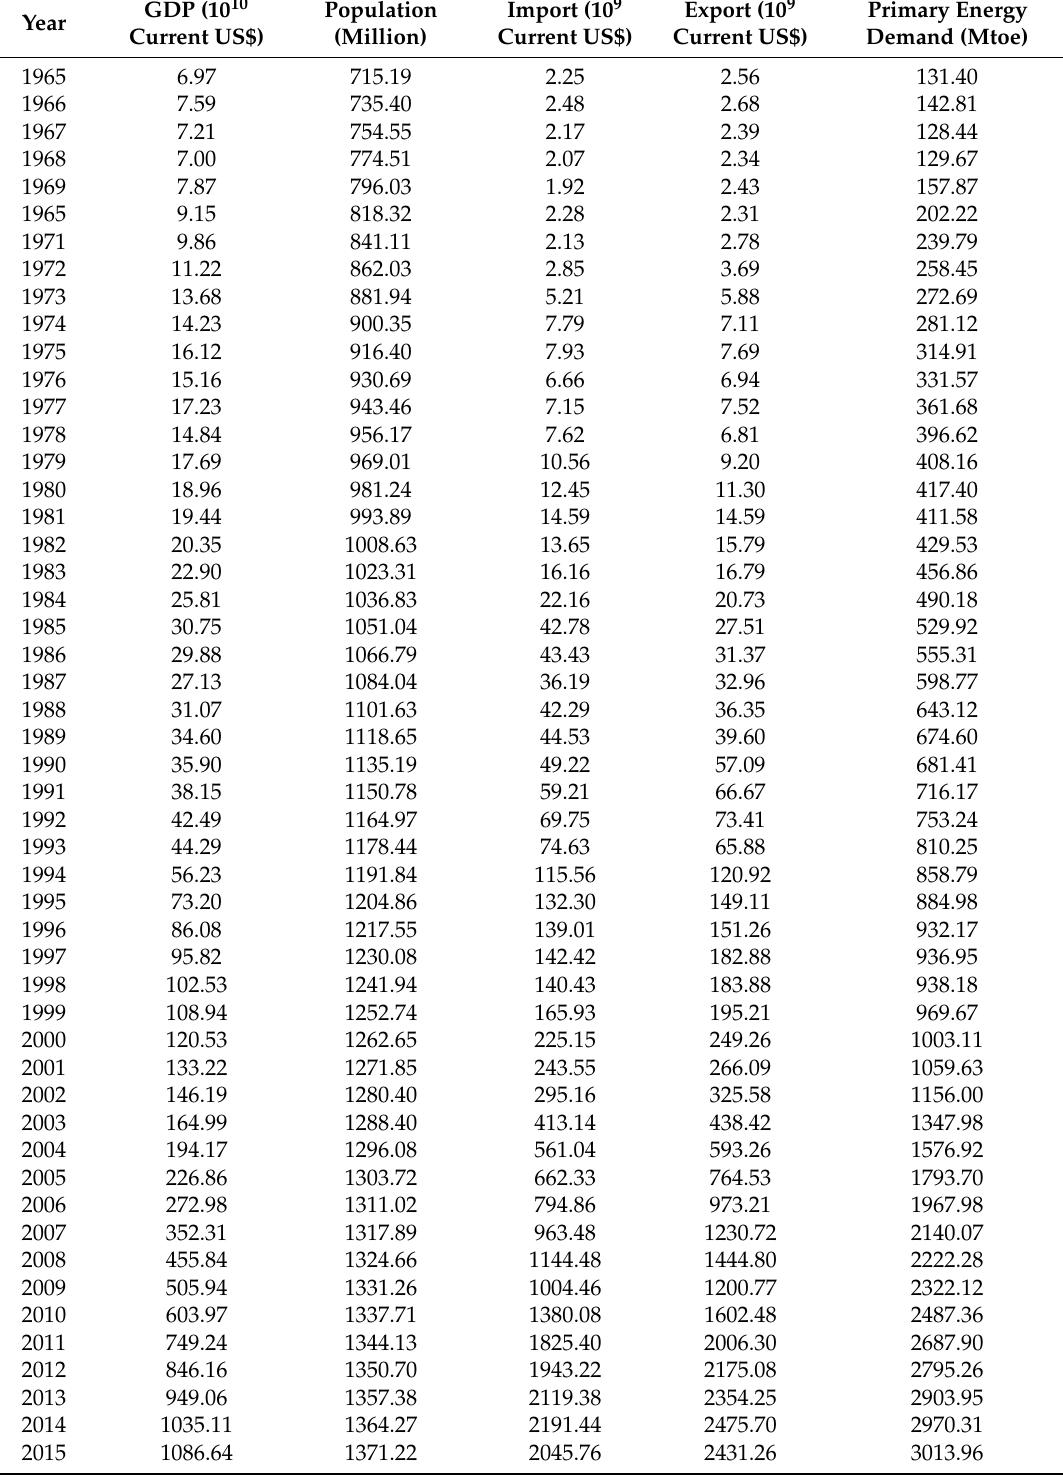
Table 1. Primary energy demand and indicator data of